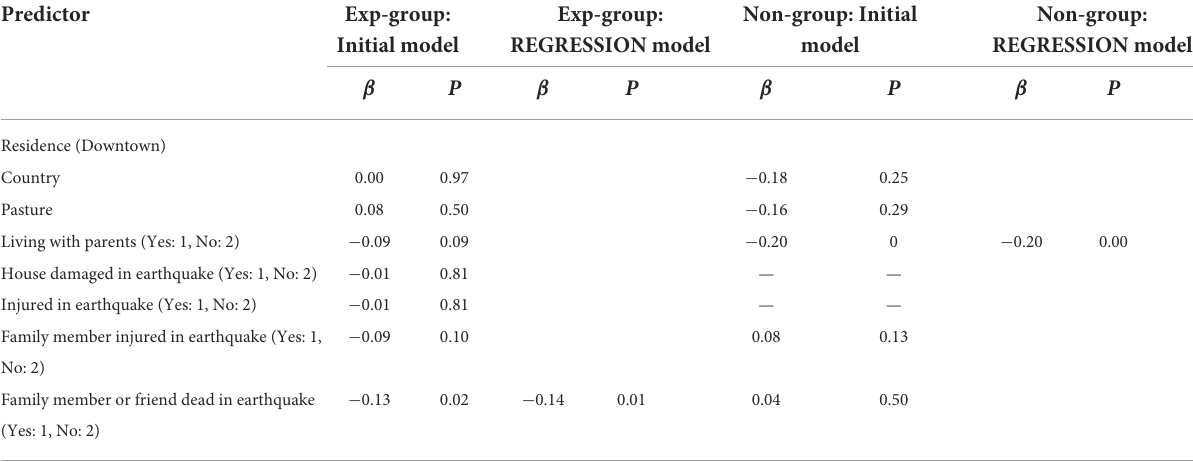
TABLE 3 Multiple stepwise regression analysis for variables predicting MCS scores across the exp-group and non-group.